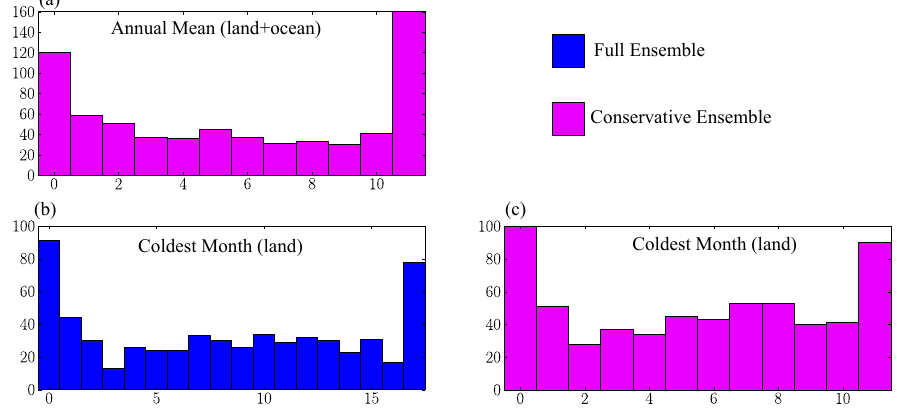
Fig. 7. Rank histograms for the three out of the eight ensembles analysed for the mid-Holocene which passed the statistical test for reliability. They nevertheless show a tendency towards being too